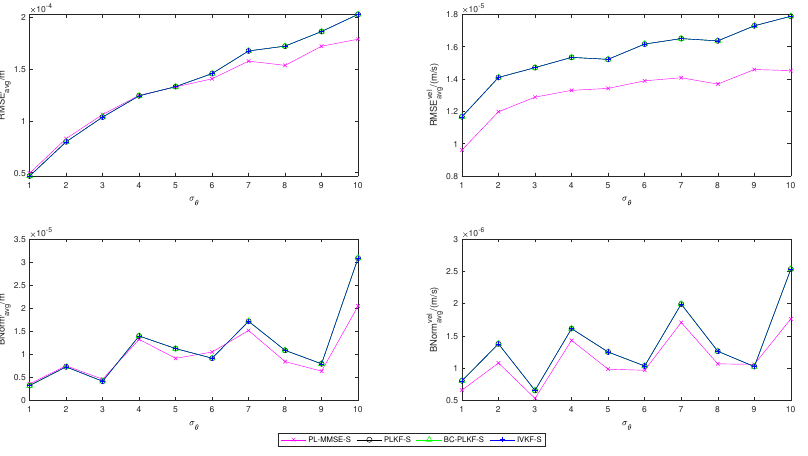
Figure 10. Time-averaged RMSEs, BNorms and bearing noise standard deviation at V = 10 − 4 m/s for the four algorithms combined with the linear approximation method.